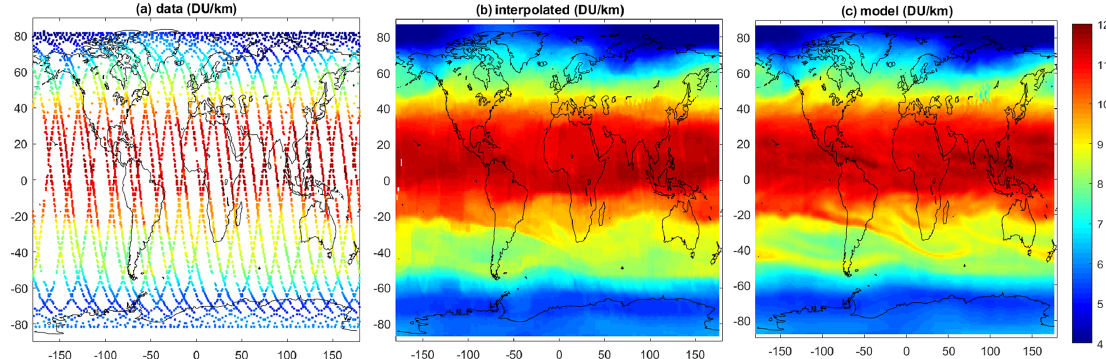
Figure 8. (a) Ozone at limb satellite measurements at 10hPa on 1 September 2018. (b) Interpolated ozone at 10hPa. (c) The corresponding adjusted SILAM ozone field at the same pressure level.